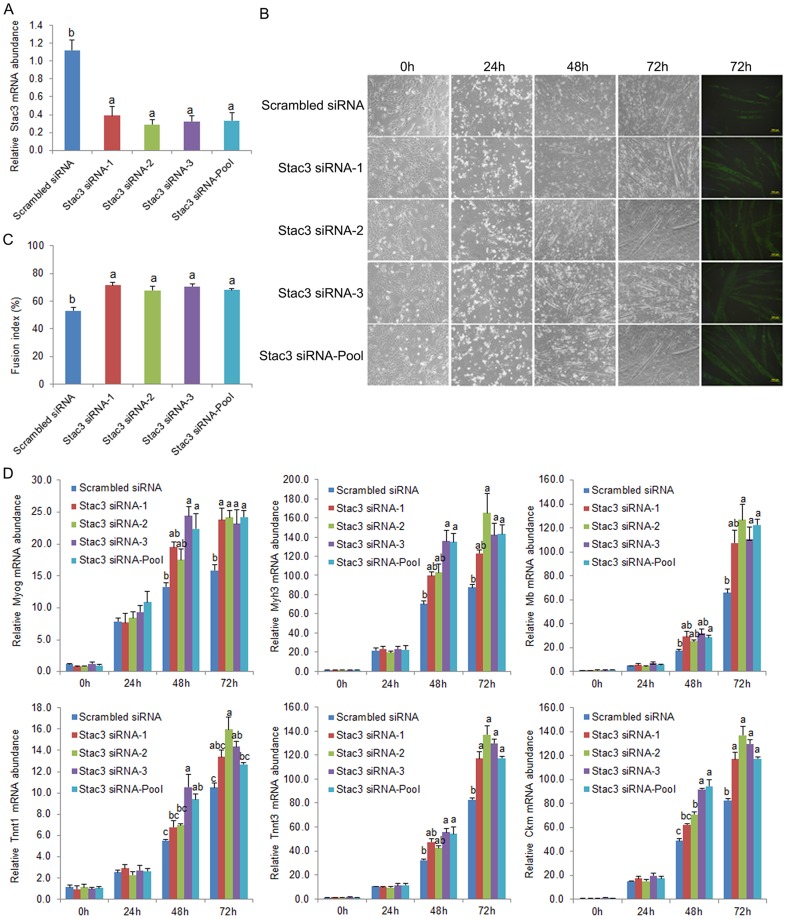
Effects of individual and pooled Stac3 siRNAs on differentiation of C2C12 myoblasts.Three Stac3 siRNAs (MSS239387, MSS239388, and MSS239389 from Invitrogen, Carlsbad, CA; indicated as Stac3 siRNA-1, -2, and -3, respectively, in the graphs) were transfected into C2C12 myoblasts separately (30 nM) or in combination (10 nM each). Transfection with 30 pmol of a scrambled siRNA (Invitrogen) was used as the control. Following transfection, the cells were maintained in growth medium or induced to differentiate into myotubes in differentiation medium. (A) Relative expression levels of Stac3 mRNA at 48 h after transfection. (B) Representative images of C2C12 cells at 0, 24, 48, and 72 h of differentiation. Cells at the far right were stained with anti-myosin heavy chain antibody (MF20, Developmental Studies Hybridoma Bank, University of Iowa, Iowa City, IA). (C) Fusion index at 72 h of differentiation. Fusion index was calculated as the percentage of total nuclei that resided in cells containing 3 or more nuclei. (D) Relative expression levels of myogenin (Myog), myosin heavy chain 3 (Myh3), myoglobin (Mb), troponin T type 1 (Tnnt1) and 3 (Tnnt3), and creatine kinase, muscle (Ckm) mRNAs at 0, 24, 48, and 72 h of differentiation. Data are expressed as means ± s.e.m. (n  =  3 independent cell cultures). Bars not labeled with the same letter are statistically different (P<0.05).